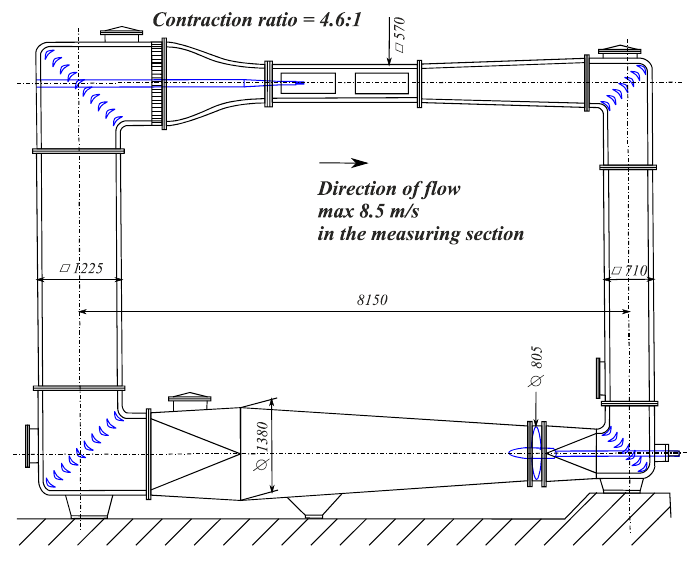
Figure 9. University of Geneva (UNIGE) cavitation tunnel.